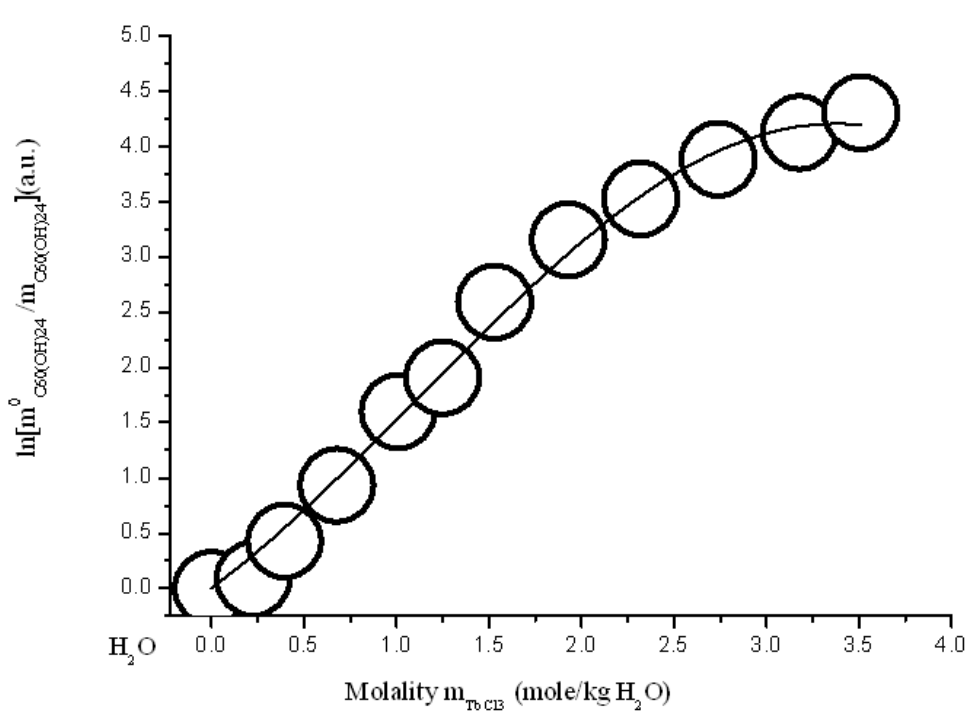
Figure 17. Branch of crystallization С 60 (ОН) 24 *18Н 2 О in the diagram of solubility in ternary system С 60 (ОН) 24 —TbCl 3 — H 2 O at 25 °C (convex-conxave 𝜎 − 𝑖𝑑 line—calculation according to modified three-parameter Sechenov equation SEM-3 (15)).